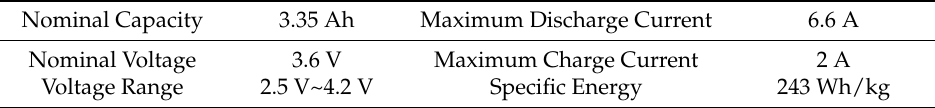
Table 1. LiB Parameters.